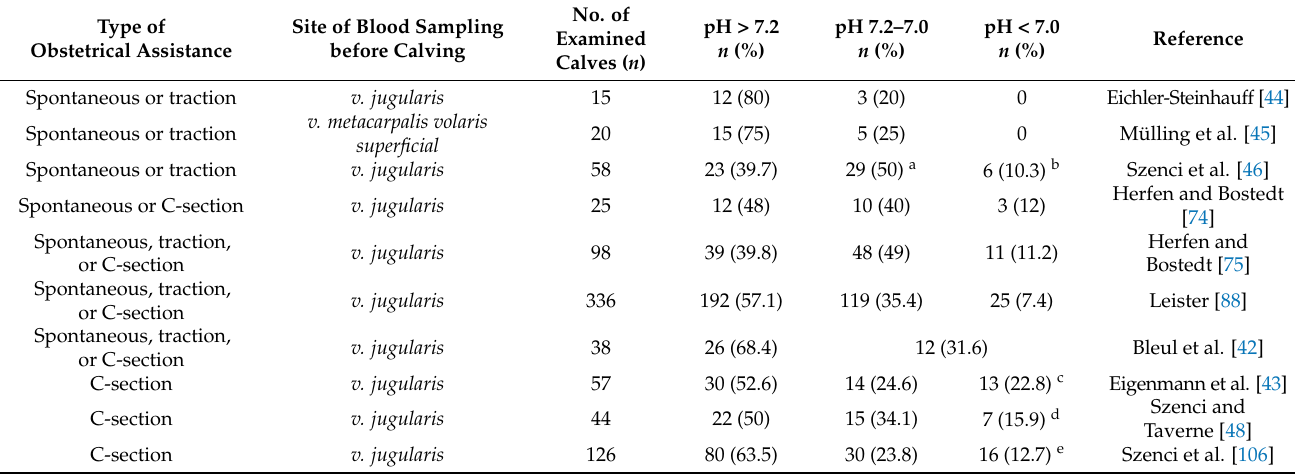
Table 8. Prevalence of physiological, moderately, and severely acidotic newborn calves immediately after obstetrical